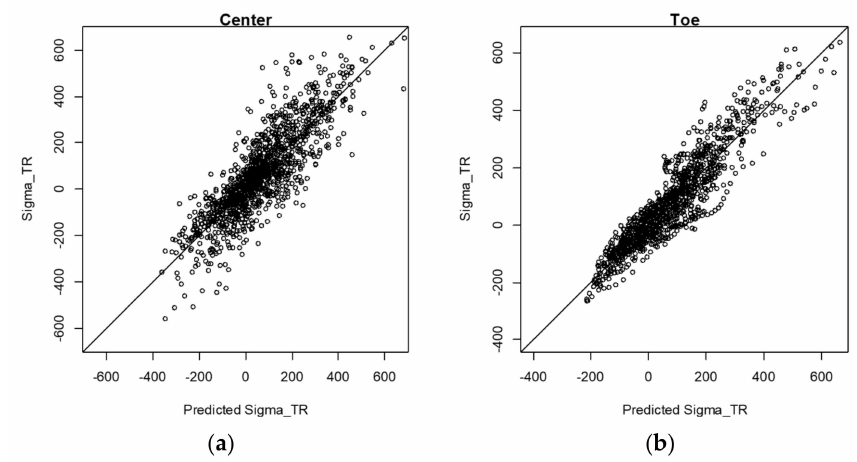
Figure 18. Comparison between the predicted value of the mean residual stress σ MR and that calculated by thermal elastoplastic analysis: ( a ) The predicted ( X -axis) and calculated ( Y -axis) σ MR for the welding center and ( b ) the predicted ( X -axis) and calculated ( Y -axis) σ MR for the welding toe. Figures 19 and 20 show the FE-calculated and predicted values of the residual stress with respect to the position ( z ) of the residual stress, the thickness ( B ) of the member, the yield stress ( σ Y ), and the constraint ( K s ) for the welding center and the toe, respectively. In Figures 18 and 19, the X - and Y -axes denote σ TR / σ Y and z/B , respectively. The values in parentheses denote the position, the thickness, the yield stress ( σ Y ), and the degree of constraint ( K s ). The residual stress values obtained using the predictive model and thermal elastic–plastic analysis agree well. It is noteworthy that the residual stress at a 25 mm thickness shows a different trend from those for 50 and 70 mm thicknesses. Thus, the prediction model expresses all the different residual stress characteristics well.